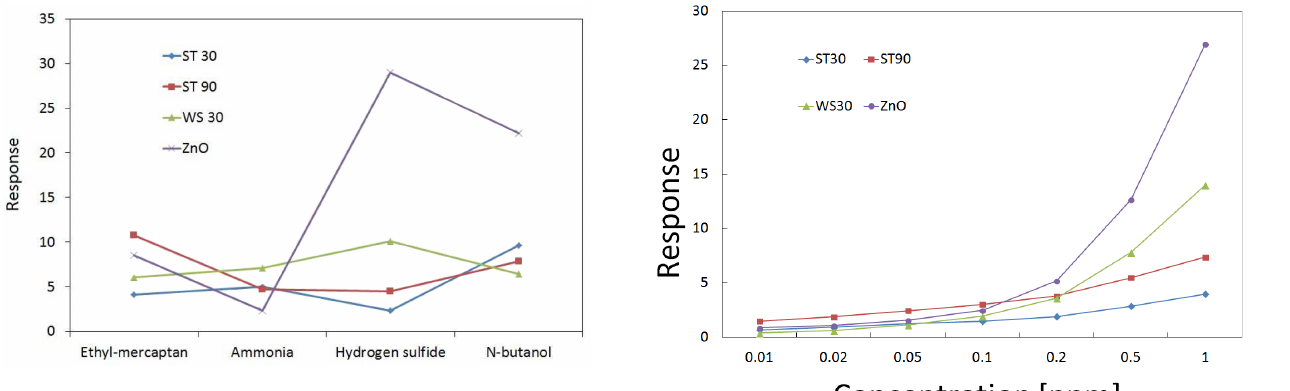
Figure 1. Best responses for each sensor at own working tempera- ture both to gases of interest and to reference gas n-butanol, under dry conditions. Figure 2.